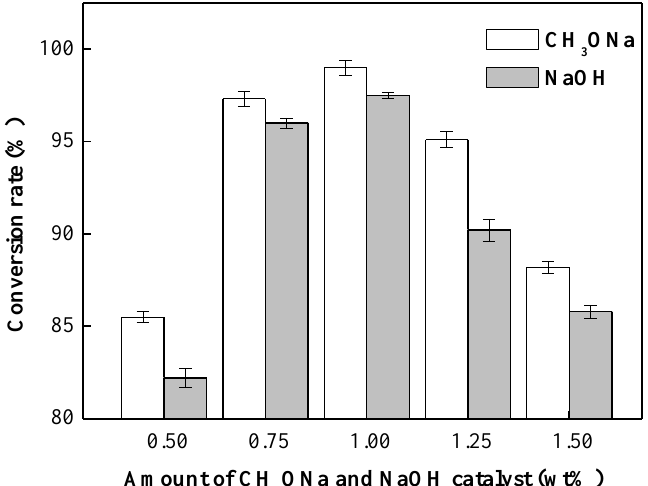
Figure 2. Effects of catalysts type and amounts of catalysts on the transesterification reaction. Reaction conditions: methanol-to-oil molar ratio, 9:1; amount of catalyst used, 0.5–1.5 wt %; rotation speed, 7000 rpm; reaction temperature, 65 °C; and reaction time, 8 min.